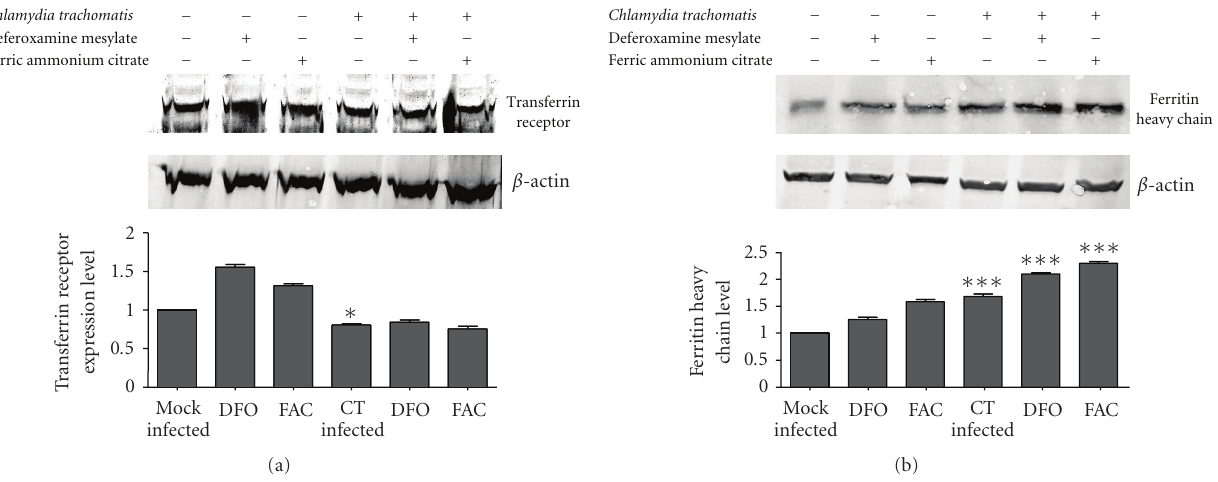
Figure 1: E ff ect of CT infection on TfR expression in HeLa cells: HeLa cells were infected at 2 moi and treated with the iron chelator DFX mesylate and ferric ammonium citrate (FAC). Mock-infected cells were considered as the control. Treated and untreated cells were harvested at 24 hpi, and the cell lysates (40 μ g) were electrophoresed on 8–12% SDS-PAGE gel, followed by Western blot analysis using anti-TfR and anti-FHC antibodies, with beta-actin as the loading control. (a) Expression of the TfR was downregulated in CT-infected HeLa cells and did not change after addition of DFX and FAC. (b) Expression of FHC was studied in CT - infected HeLa cells in comparison to control. FHC level remained above the basal level (mock) in CT - infected cells after addition of DFX. Conversely, addition of FAC led to a higher degree of induction in the FHC level of CT-infected cells than that in the control. Bars represent standard error. ∗ P < . 05 and ∗∗ P < . 01.